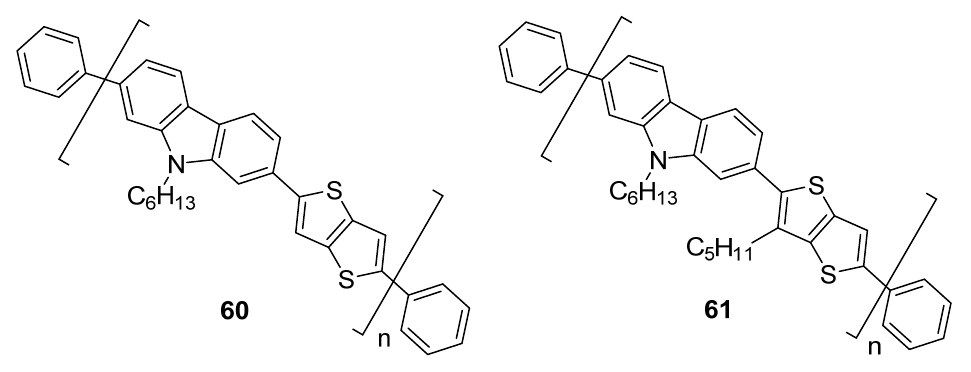
Figure 3. TT units in emitting polymers for OLEDs.